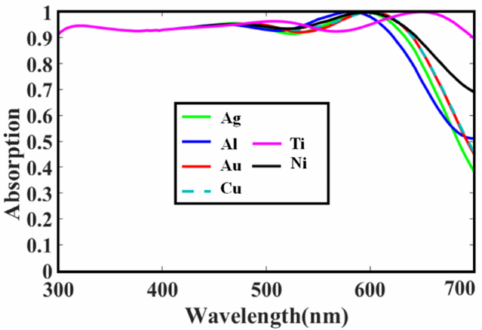
Figure 6. Influence of optical absorption e ffi ciency on di ff erent materials for the back-surface reflector.